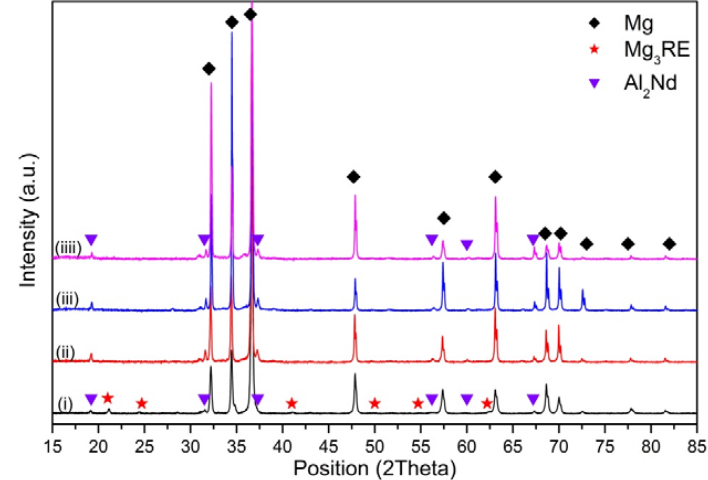
Figure 16. X-ray diffraction patterns of EL21–1.0 wt.% AlN: (i) as cast; and solutionized at: (ii) 520 ◦ C; (iii) 550 ◦ C; and (iiii) 580 ◦ C.